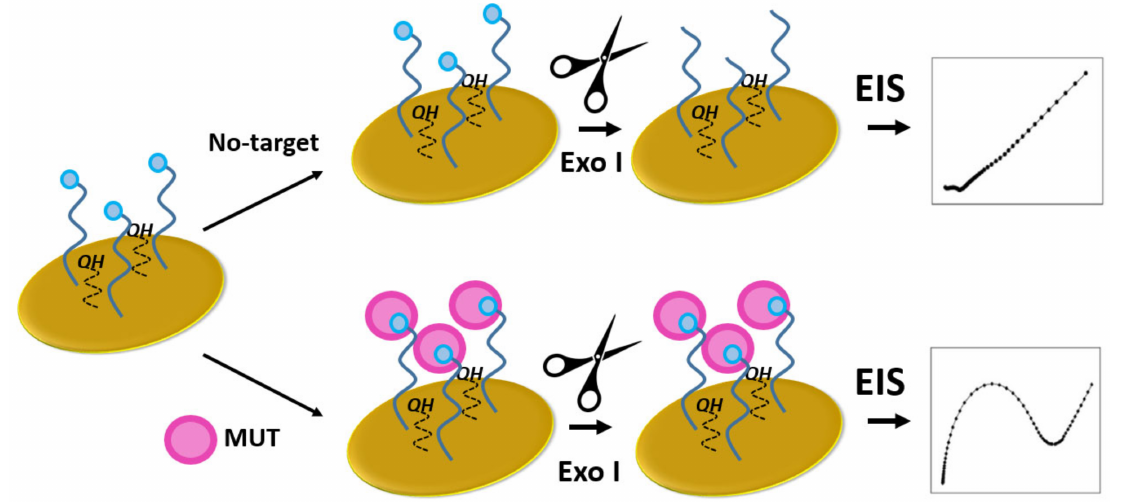
Figure 13. Schematic illustration of the label-free electrochemical impedance biosensor for protein detection based on terminal protection by hydrolysis with exonuclease I (Exo I) of small molecular linked-DNA (adapted from